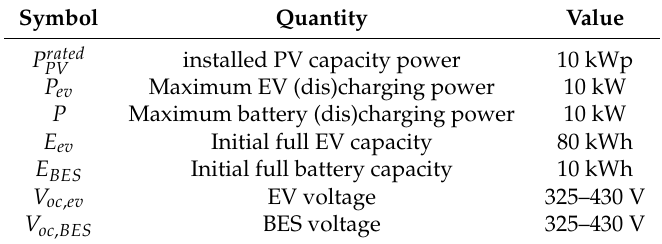
Figure 1. Schematic representation of the system: A multi-port converter including electric vehicle (EV), BES charger, photovoltaïc (PV) maximum power point tracker (MPPT), and grid connected inverter. On the AC side, a heat pump and residential load are connected. Table 1. Multi-port system